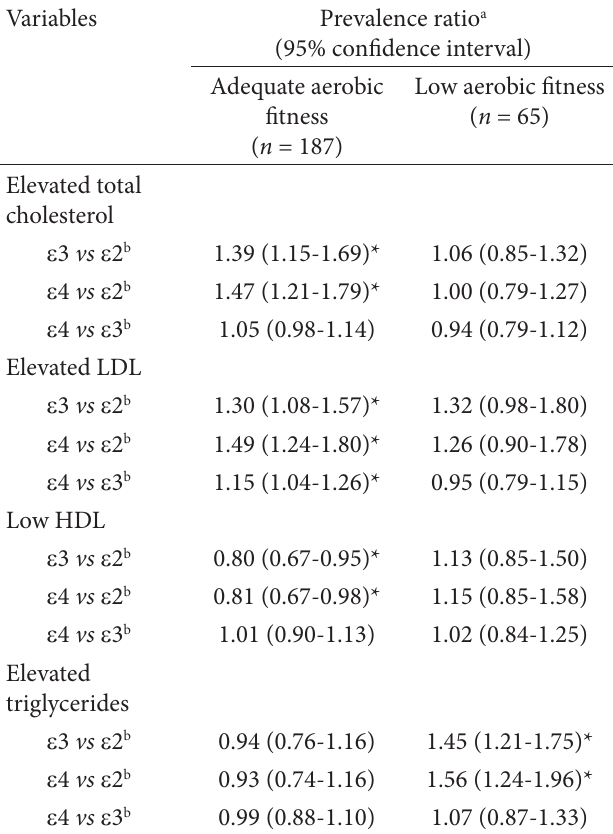
Table 3. Association between APOE alleles and elevated serum lipemia according to aerobic fitness